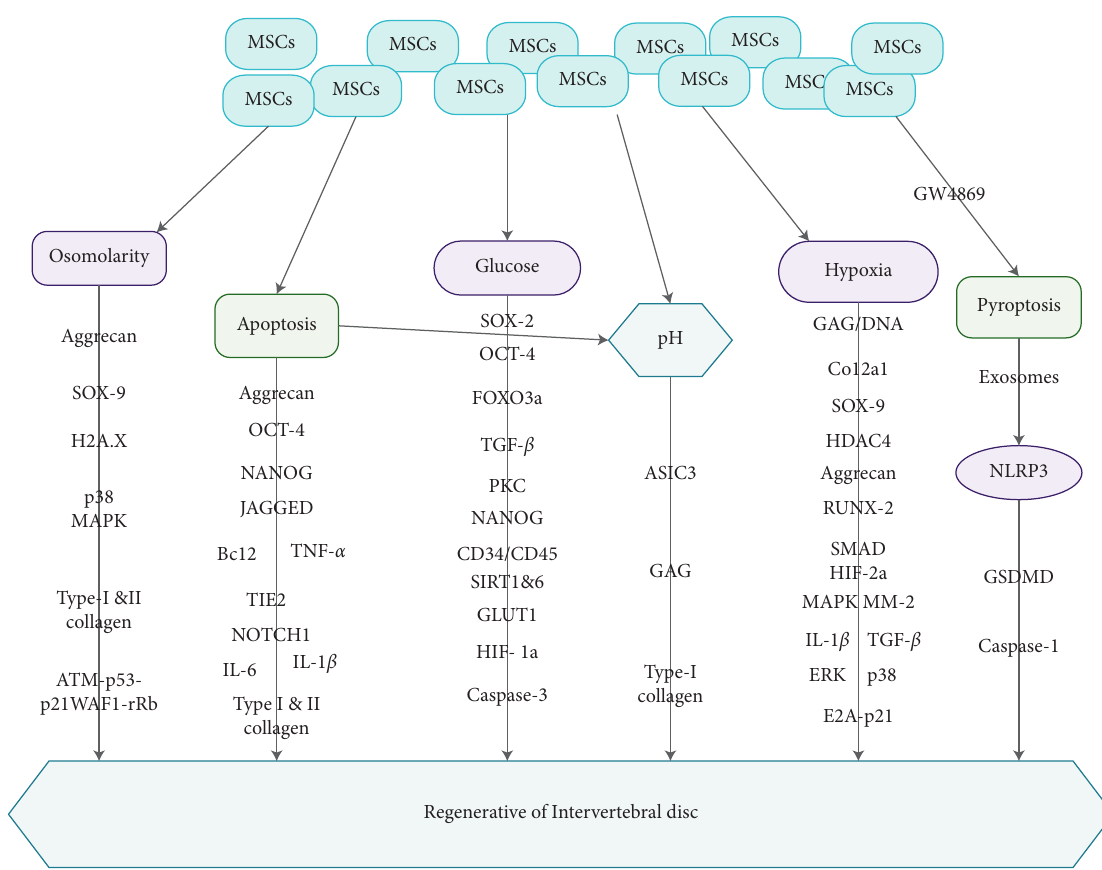
Figure 2: Illustration showing the various microenvironment clues and the pathways via which MSCs influence the repair of IVDD. MSCs influence osmolarity, apoptosis, glucose, pH, hypoxia, and pyroptosis via diverse signaling pathways contributing to the regeneration of intervertebral